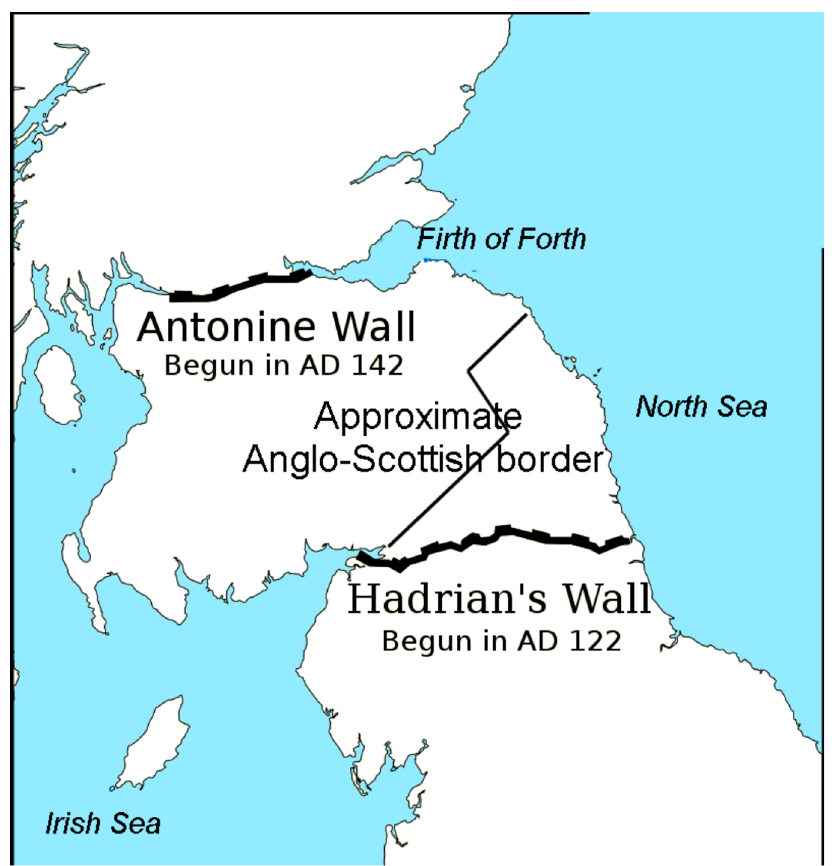
Figure 1. The position of the Antonine wall (wholly within Scotland), Hadrian’s Wall (wholly within England) and the approximate Scotland-England border (which changed at various times).